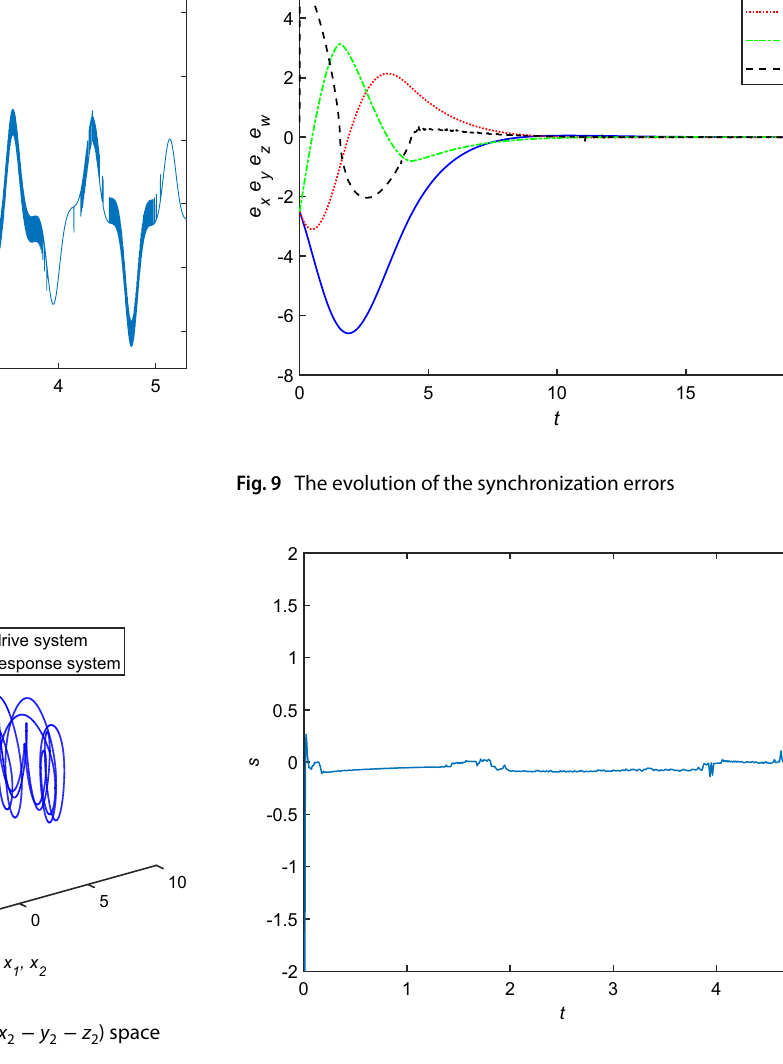
Fig. 10 The evolution of sliding mode surface